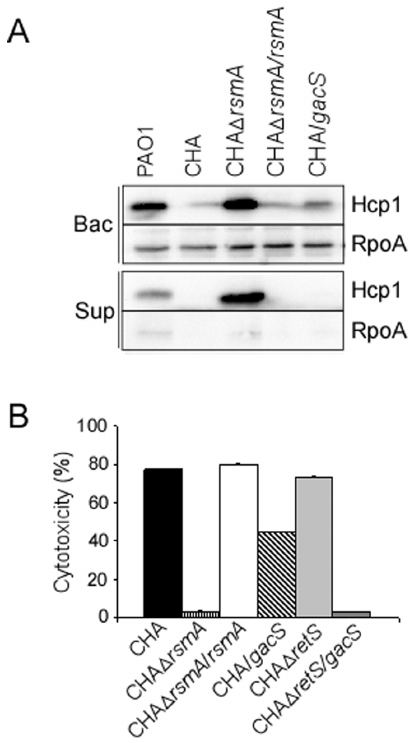
Figure 3. RsmA is responsible for absence of H1-T6SS and high T3SS activity in CHA. (A) Hcp1 synthesis and secretion were analysed by Western blot in the different strains as indicated. The cytoplasmic RpoA protein was used as a loading marker. Bac: bacteria, sup: supernatant. (B) T3SS-dependent cytotoxicity on J774 macrophages of wild-type, mutants and plasmid-complemented strains. Cytotoxicity was measured after 3 hours of infection and is expressed as a percentage of the total amount of LDH released from cells lysed with 1% Triton X-100. All tests were performed in triplicate.